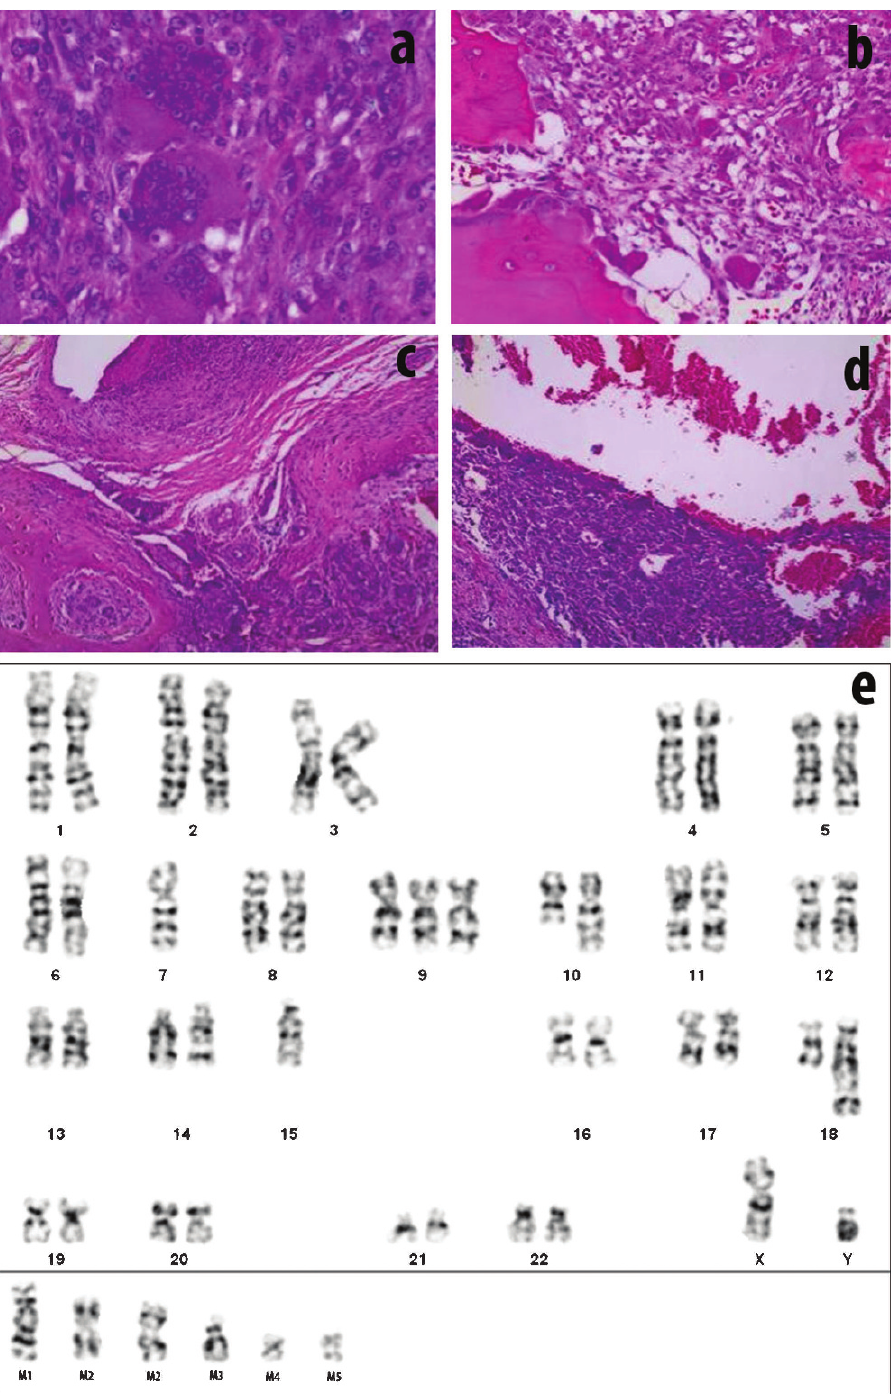
sample showing a 51, XY, 2 7, + 9, del(10)(q23), add(11)(p15) 6 2, 2 15, add(18)(q23), + mar1, + mar2 6 2, + mar3, + mar4, +